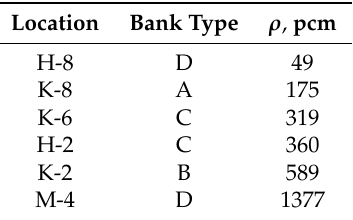
Figure 6. ( a ) Distribution of pellet and cladding surface temperatures T fs and T ci for the full-core rod ejection accident simulation using dynamic and constant gap heat transfer coefficient models; ( b ) Distribution of radiation and gas gap heat transfer coefficients as the functions of pellet-cladding gap width for the rod ejection accident simulation using dynamic gap heat transfer coefficient model Table 3. Worth of control banks.